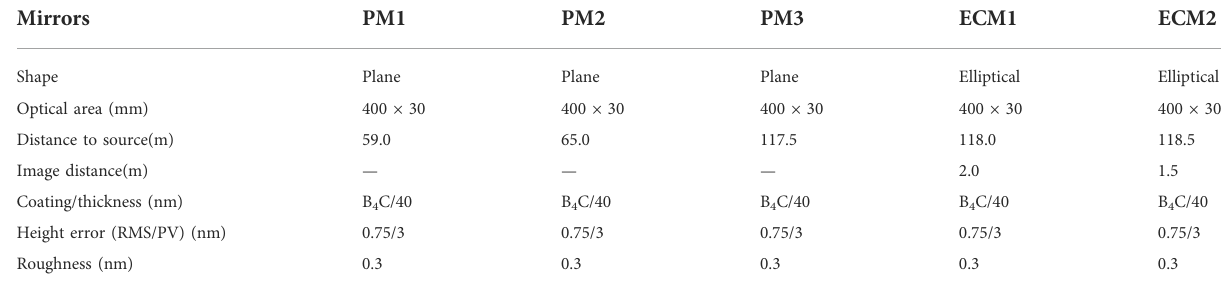
TABLE 1 Requirements of mirrors.